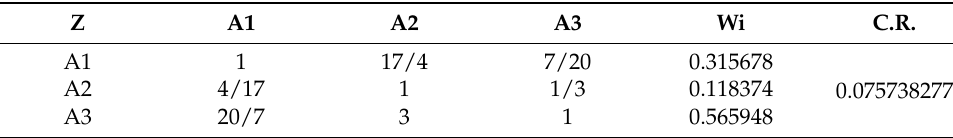
Table 8. Judgment Matrix of A1 to